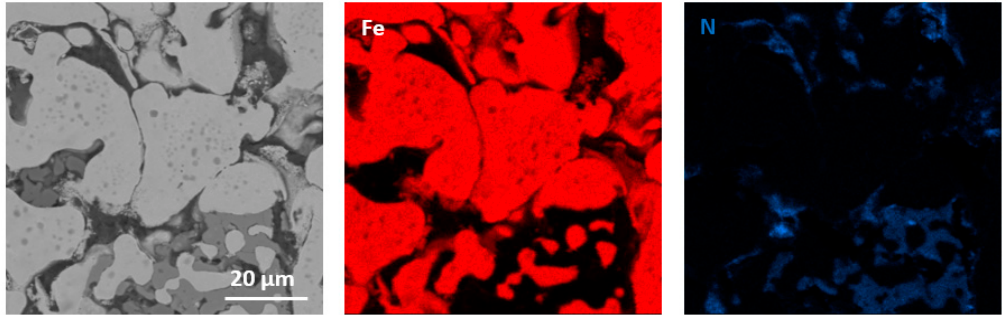
Figure 16. EDS mapping of sintered Fe with the addition of h-BN with a size of 1.5 µ m (for pressing pressure 250 MPa).